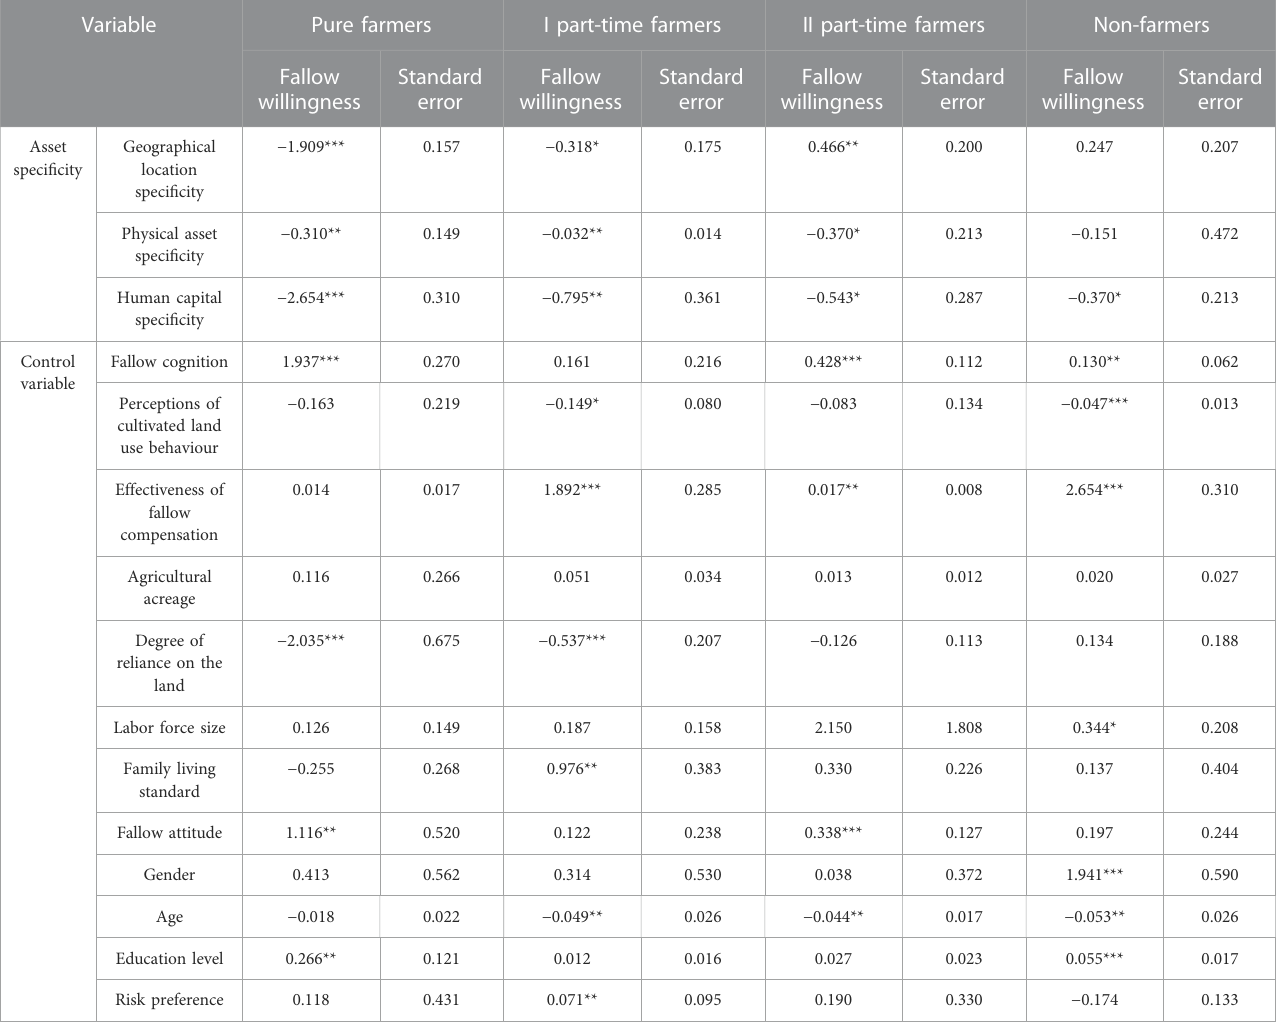
TABLE 4 Multivariate ordered logit model regression